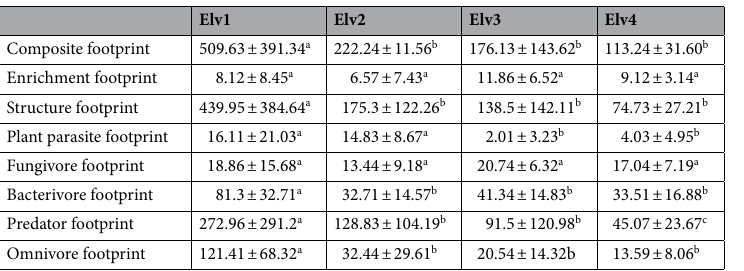
Table 3. Soil nematode metabolic footprints across elevation classes. Means followed by different superscript letters reflects significant differences by the post hoc-test ( p <